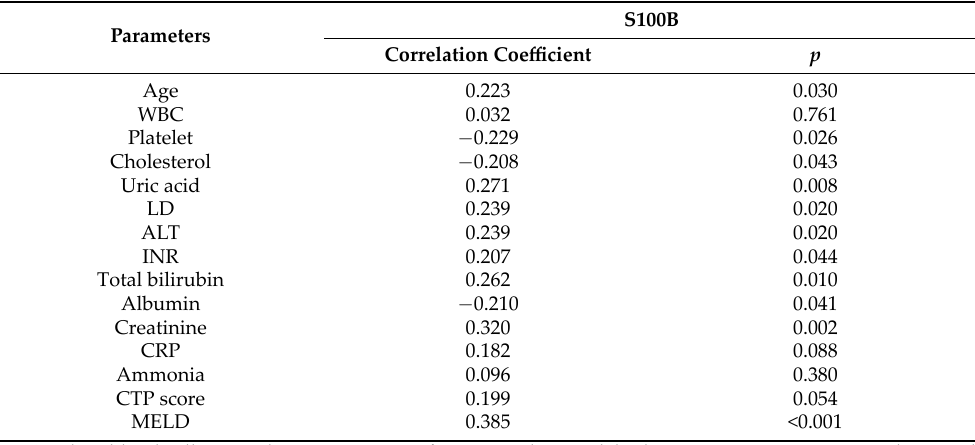
Table 4. Relationships of S100B with clinical and biochemical parameters.